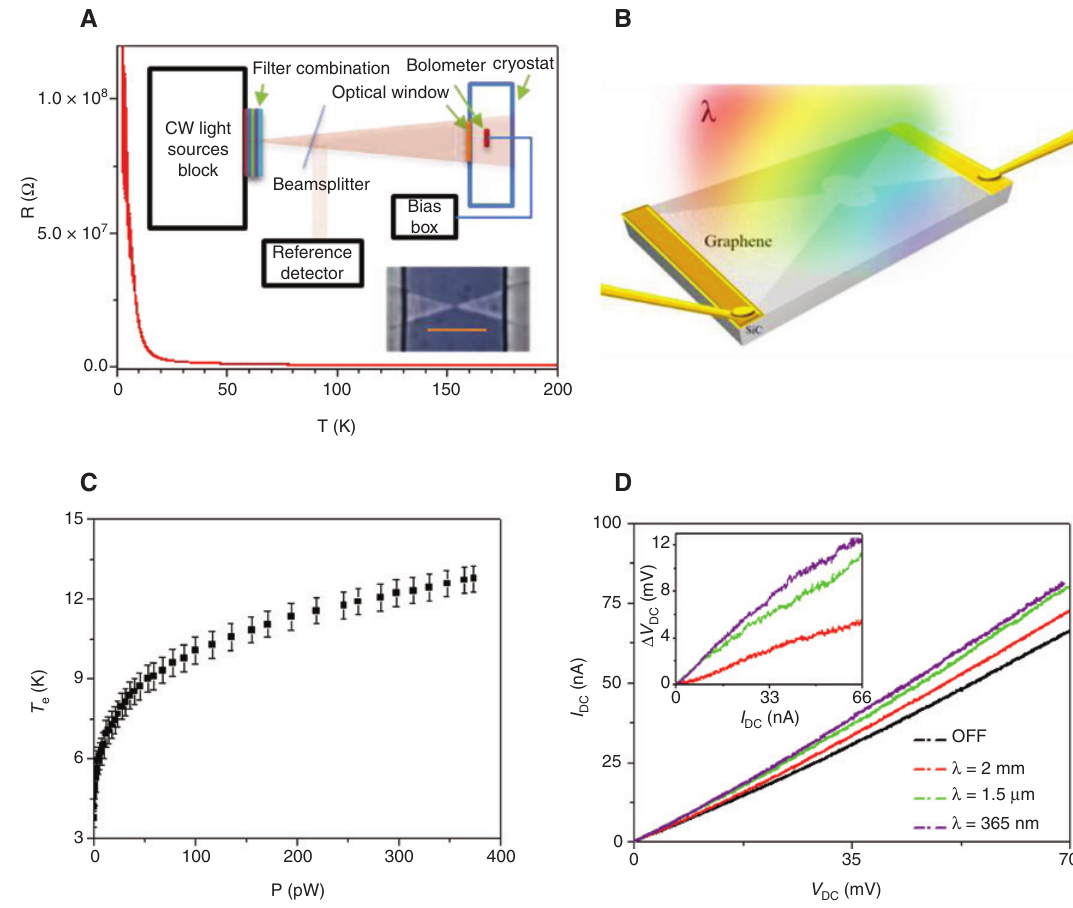
Figure 1: Ultra-broadband bolometric response. (A) Resistance as a function of temperature for a quantum dot with a diameter of 100 nm. Inset: schematic of the experimental setup and optical image of a typical quantum dot. Scale bar, 3 μ m. (B) Sketch of a typical device with broadband radiation. (C) Electron temperature as a function of Joule power for a quantum dot with a diameter of 200 nm. (D) IV characteristic of a 200 nm dot without radiation (OFF, black) and with radiation at 2 mm (red), 1.543 mm (green), and 365 nm (purple) wavelength, having absorbed power of 0.4, 1.0, and 1.4 nW, respectively. Inset: response Δ V as a function of the current I at the same DC DC